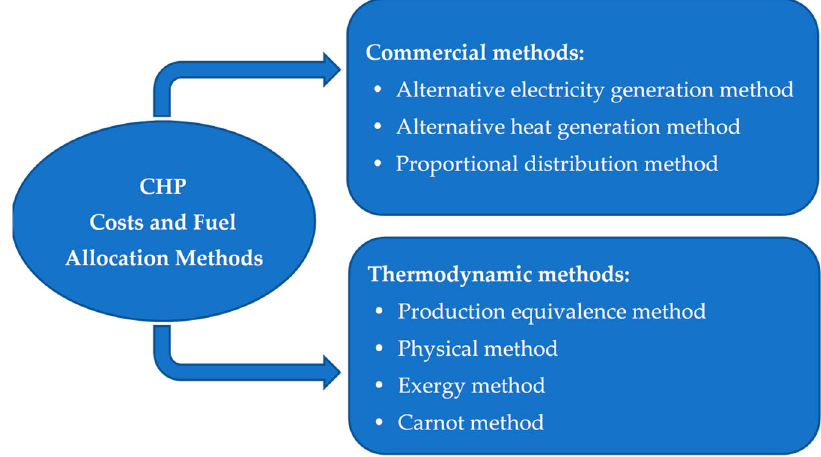
Figure 1. Methods of allocating costs and fuel in cogeneration.